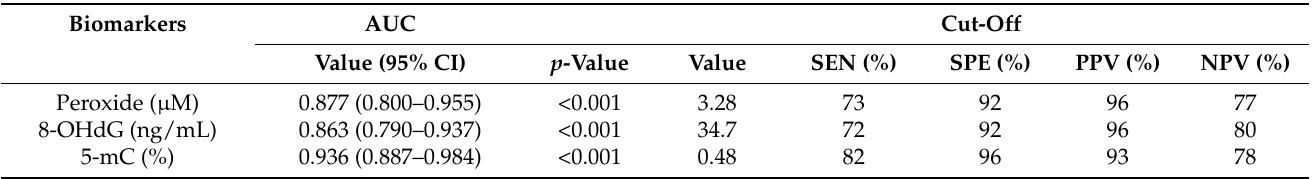
OR, odds ratio; CI, confidence interval; 5-mC, 5-methylcytosine; 8-OHdG, 8-hydroxy-2-deoxyguanosine; MDA, malondialdehyde; AUC, area under the curve; CI, confidence interval; SEN, sensitivity; SPE, specificity; PPV, positive predictive value; NPV, negative predic- tive